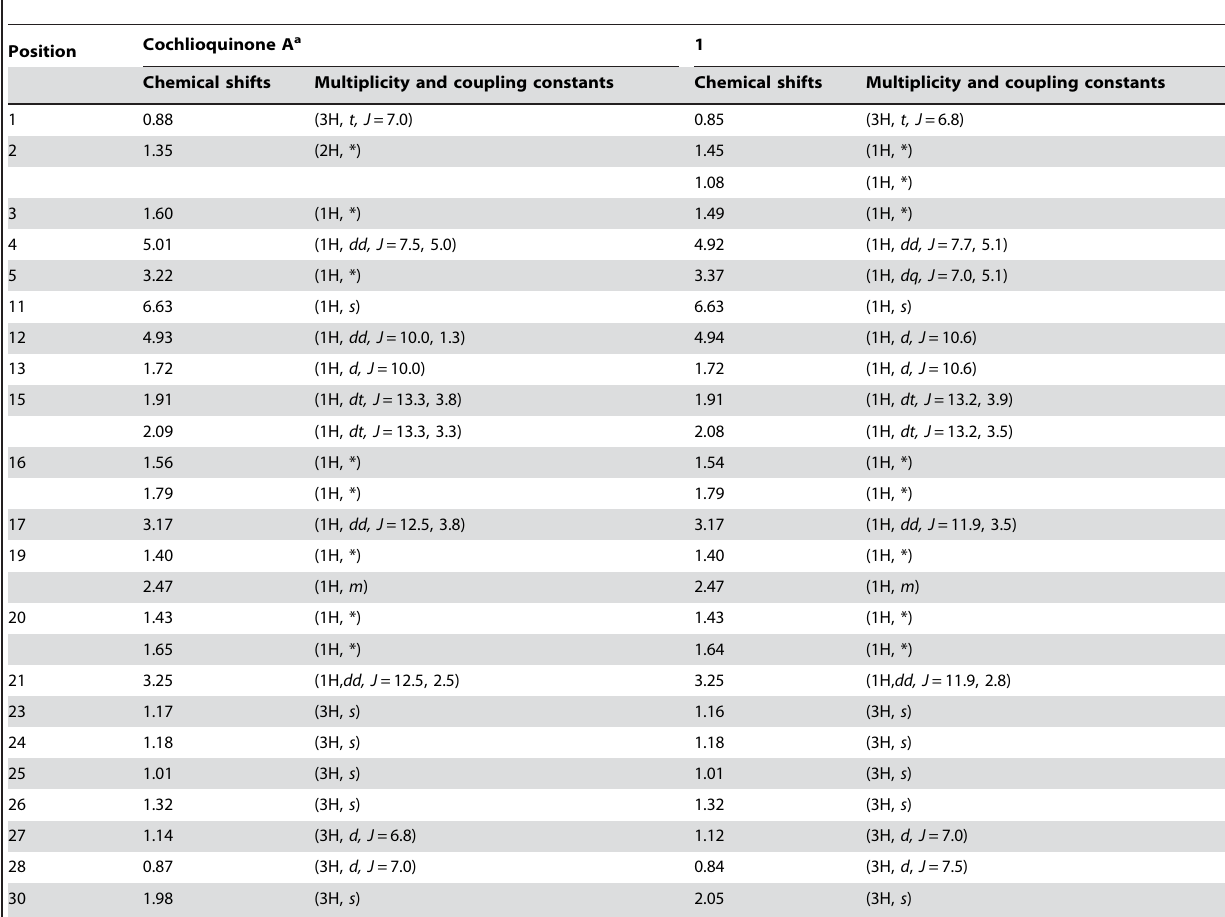
Table 2. 1 H-NMR and HSQC spectral data of 1 and comparison with literature data for cochlioquinone A.